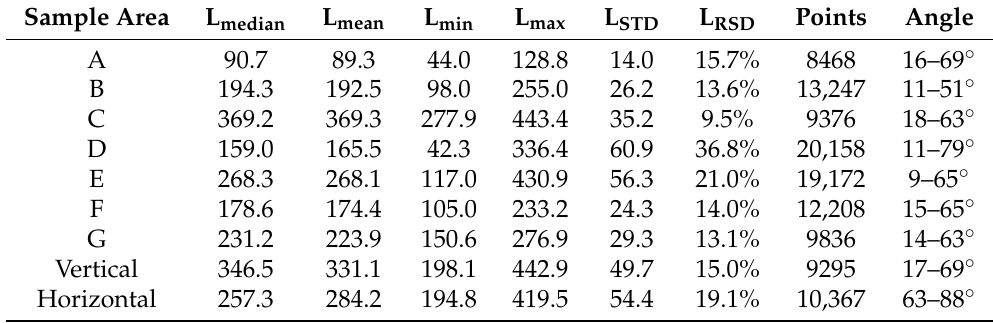
Table 11. The sample areas A–G: median luminance, Gaussian mean luminance, minimum luminance, maximum luminance, standard deviation, relative standard deviation, number of points, and